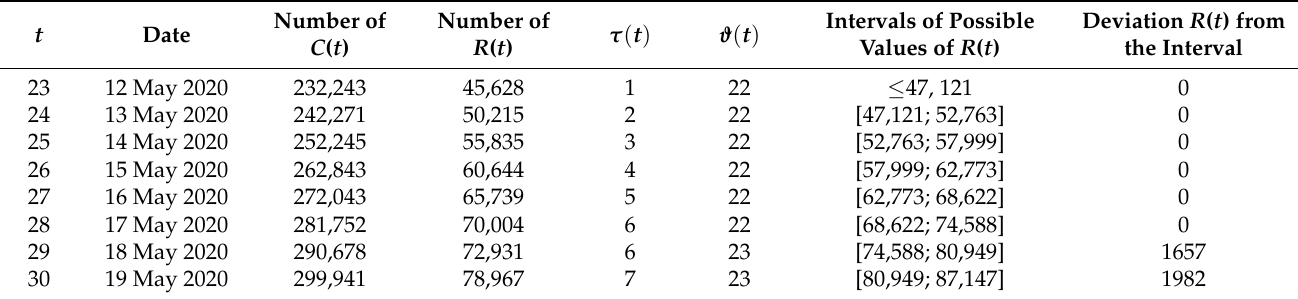
Table 1. Values of the dynamic balance characteristic and its assessment (period from 12 May to